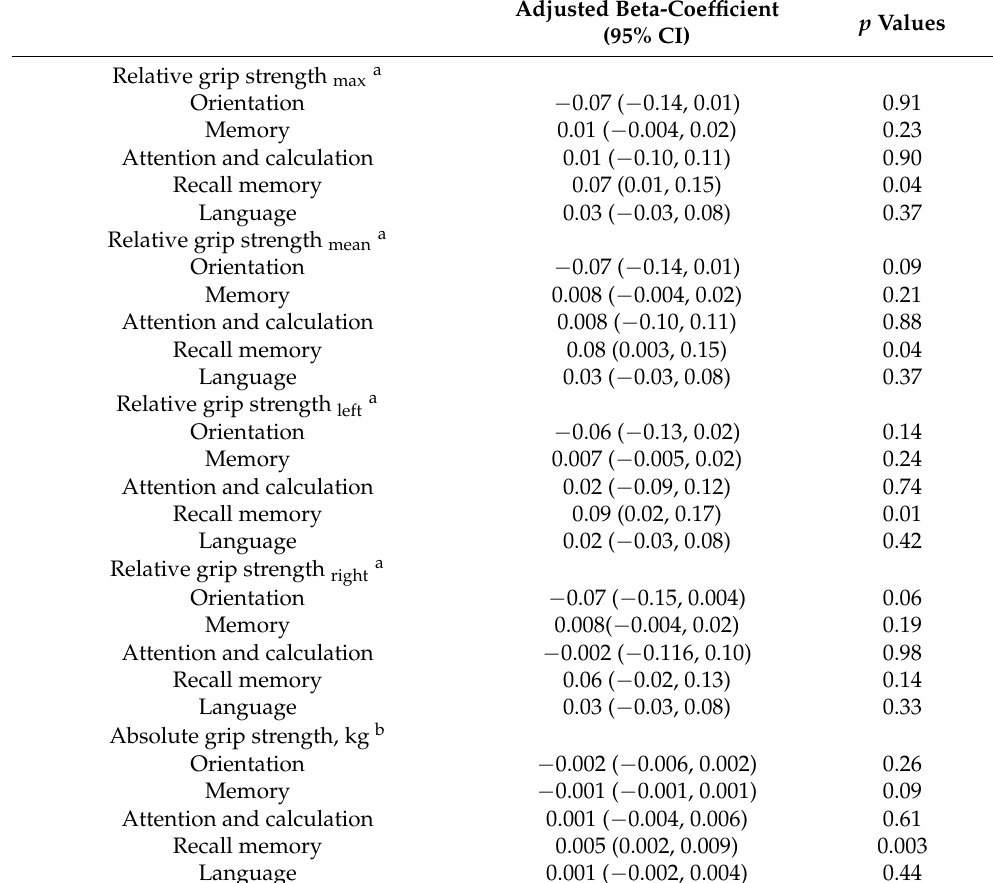
Table 5. Multivariable linear regression of handgrip strength on Mini Mental State Examination (MMSE), all sub-components.